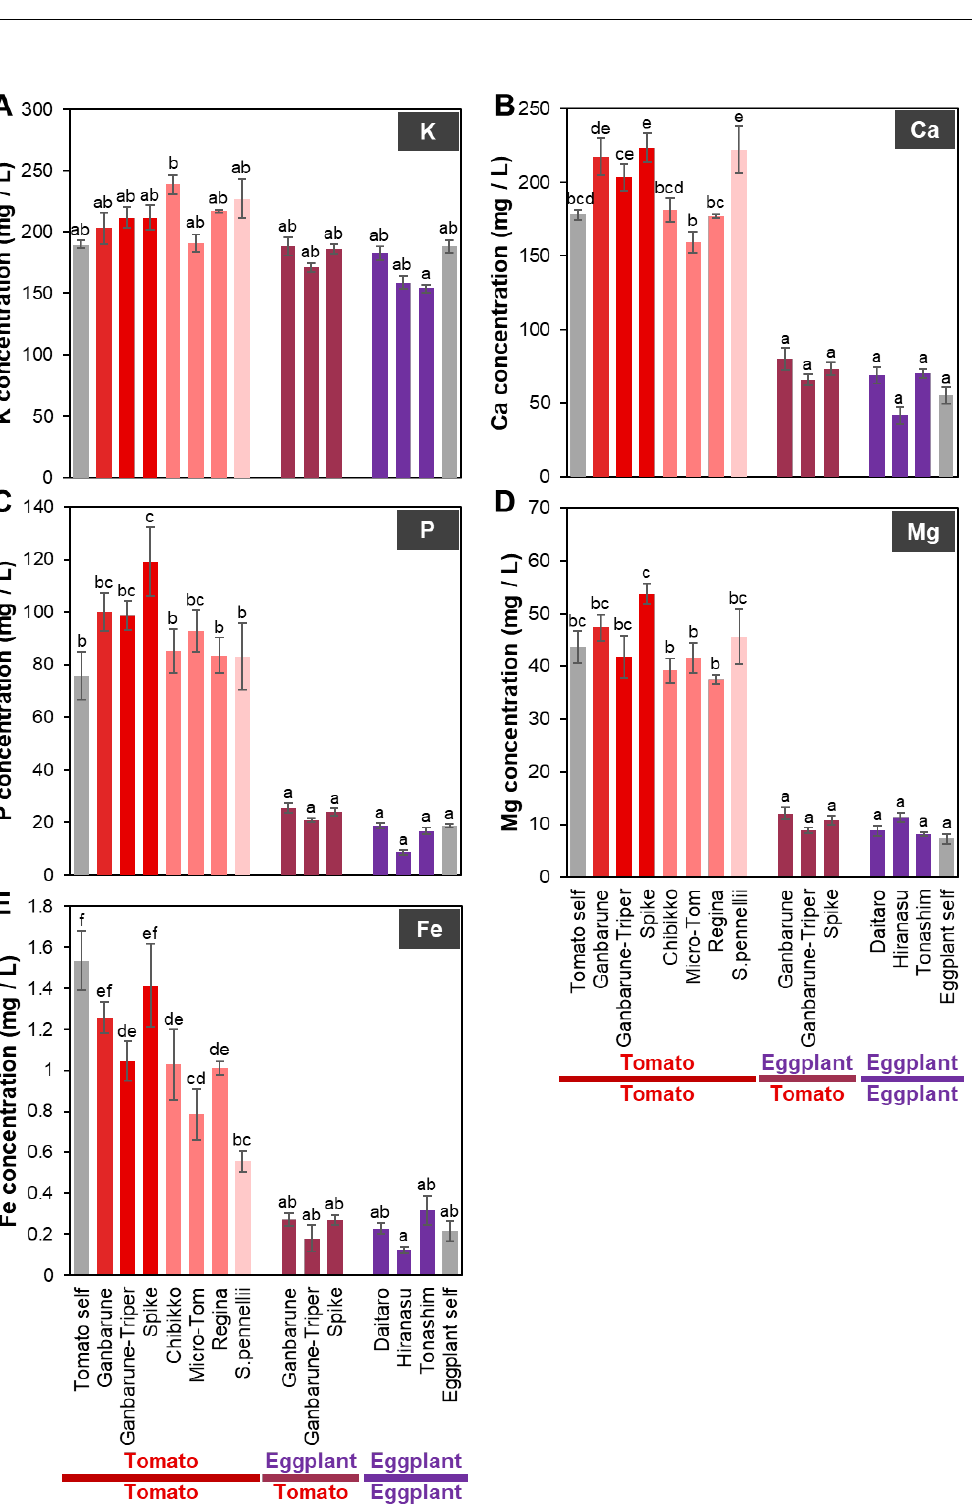
Figure 1. The concentrations of macroelements in the xylem exudate of various grafting combinations. The concentrations of K ( A ), Ca ( B ), P ( C ), Mg ( D ), and Fe ( E ) in the xylem exudate of various grafting combinations. Gray, red, red–pink, pink, red–purple, and purple indicate self-grafted plants, tomato grafted onto various rootstocks of tomato cultivars, tomato grafted onto various dwarf tomato cultivars, tomato grafted onto wild tomato, eggplant grafted onto various tomato cultivars, and eggplants grafted onto various eggplant cultivars, respectively. Different letters indicate significant differences according to the Tukey-Kramer test ( p ≤ 0.05). Values are the means of four replicate samples, and error bars indicate the standard error of four replicate